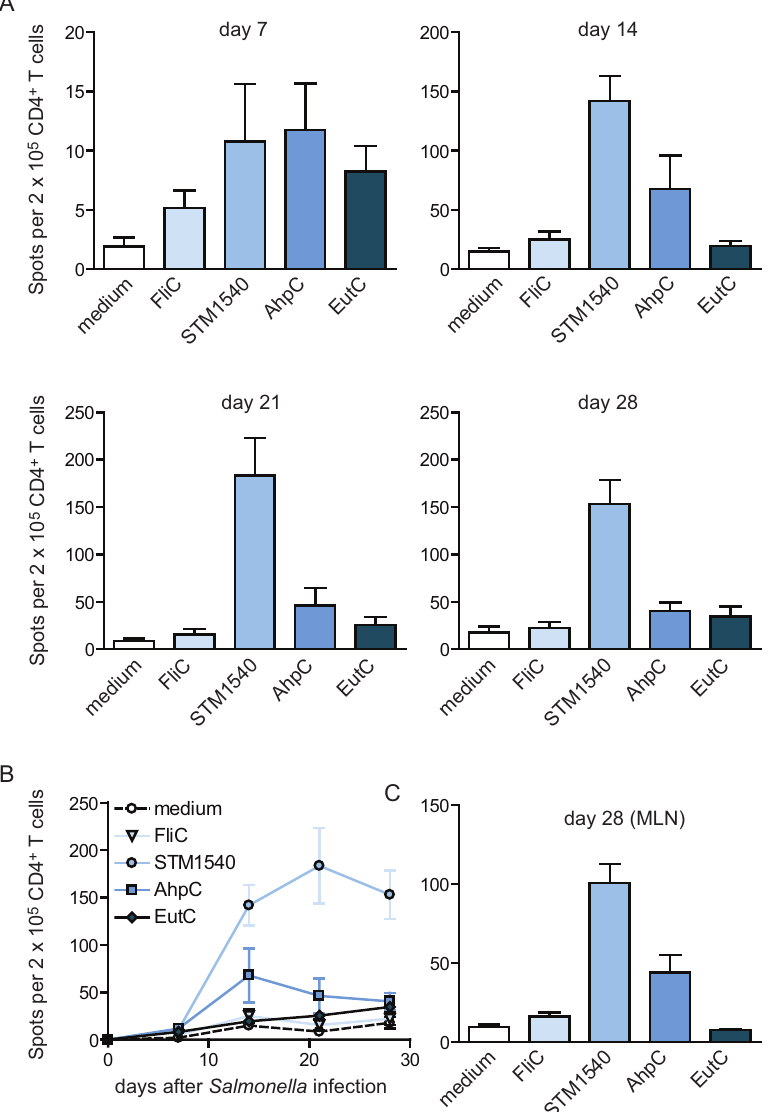
Figure 3. Tracking of CD4 + T cell responses during virulent Salmonella infection. C57BL/6 mice were infected orally with virulent Salmonella Typhimurium and at day 7, 14, 21 and 28 post-infection CD4 + T cells were isolated from the spleen and restimulated with dendritic cells that were either loaded with different Salmonella peptide epitopes (AhpC 154–168 , EutC 243–257 , STM1540 262–276 and FliC 429–443 ) or not loaded with peptide (medium). (A) Graphs show the number of IFN- c + spots per 2 6 10 5 CD4 + T cells, as measured by ELISPOT assays, for each epitope at the indicated timepoints post-infection. (B) Graph shows similar data as in (A) depicted as the IFN- c + spot frequency in time. (C) Graph shows the number of IFN- c + spots per 2 6 10 5 CD4 + T cells that were purified from mesenteric lymph nodes (MLN) at day 28 post-infection. All graphs show mean and SEM of 5– 6 mice per group. Experiments were performed twice with similar results.